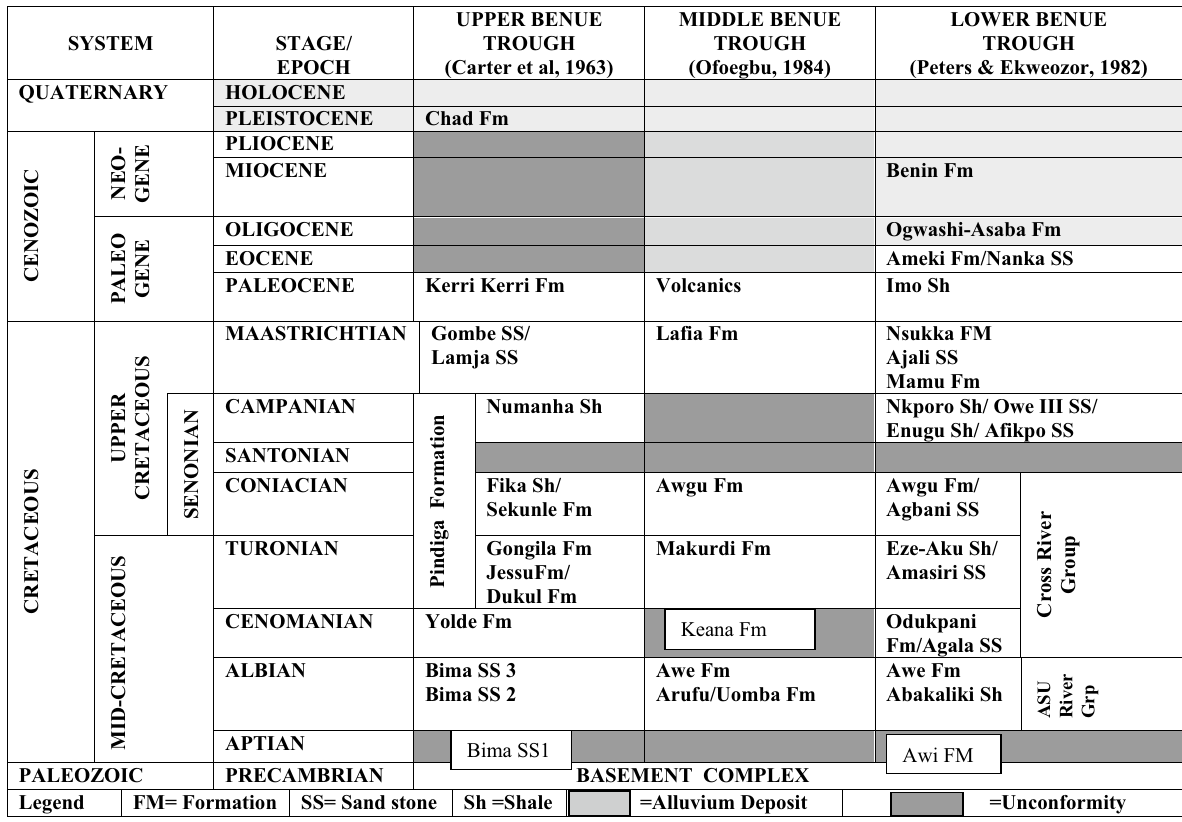
Table 1 The stratigraphic sequence of the Benue Trough of Nigeria; the red boxes indicate the coal bearing formations (modified after Ehinola